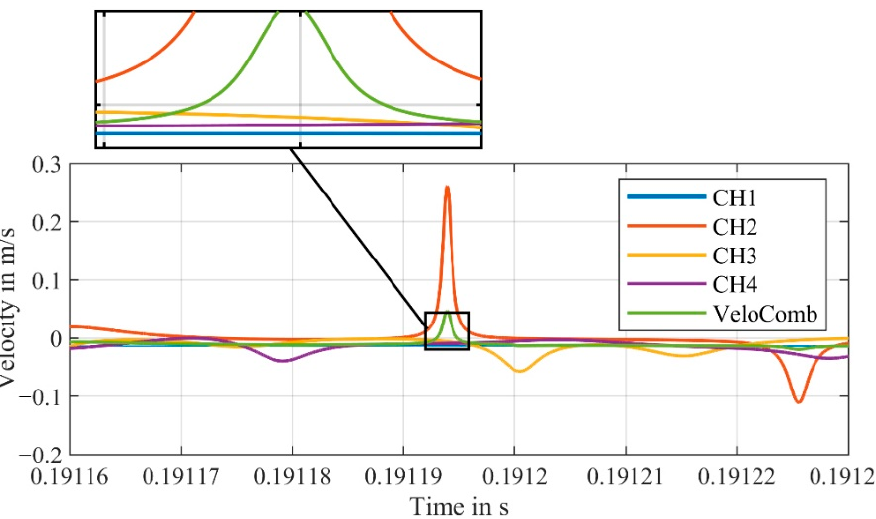
Figure 5. Detailed view of the velocity signals of the individual channels (CH1–CH4) as well as the combined signal (VeloComb); (RBW = 2.5 Hz).